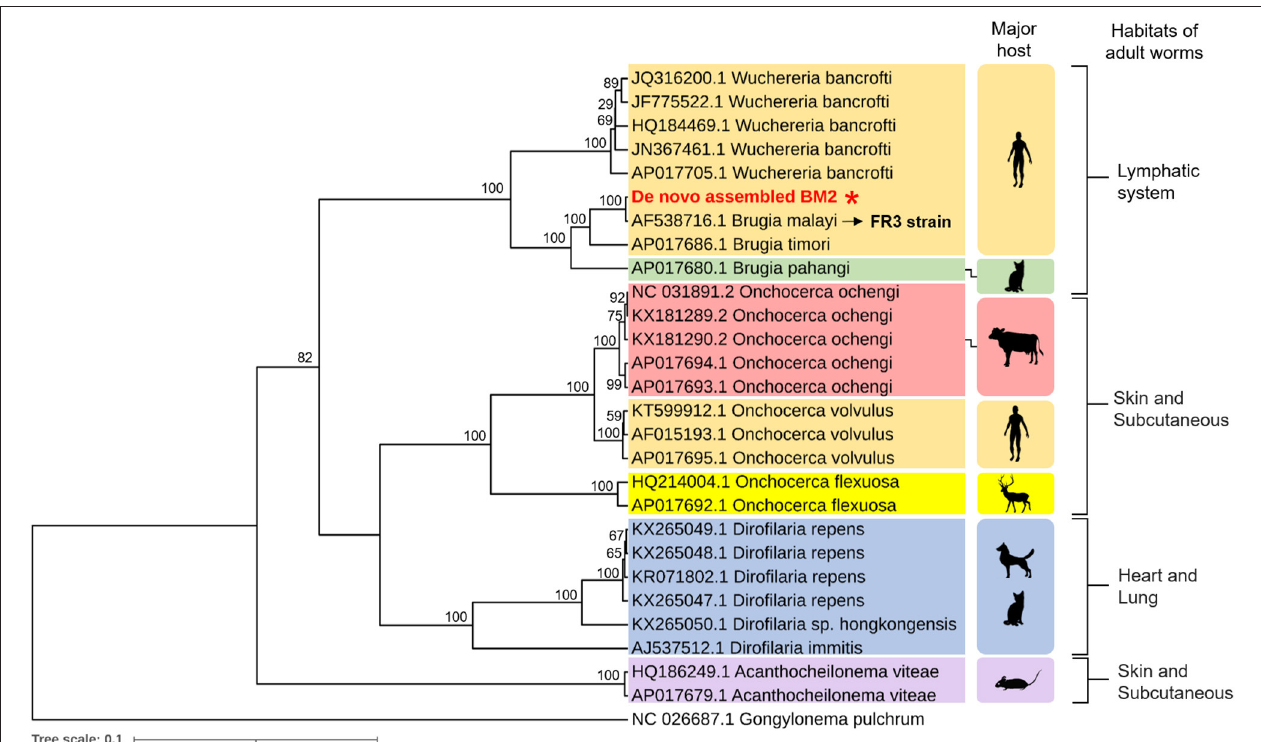
FIGURE 2 | Phylogenetic analysis of mt genome. The protein sequences of all 12 annotated mitochondrial genome of causative agents of human filariasis ( B. malayi , B. timori , B. pahangi , W. bancrofti , Loa loa , and Onchocera volvulus ), zoonotic filariasis ( B. pahangi , Dirofilaria repens , and D. immitis ), and cutaneous onchocerciasis in cattle ( O. ochengi ), onchocerciasis in deer ( O. flexuosa ), and rodent filariasis ( Acanthocheilonema viteae ). Major hosts and their habitats of adult worms within the host are indicated on right hand side. The protein sequences of all 12 annotated mt genome of de novo assembled BM2 was compared to that of B. malayi FR3 strain (accession no. AF538716). The mt genome of Gongylonema pulchrum , a free-living nematode, was used as outgroup